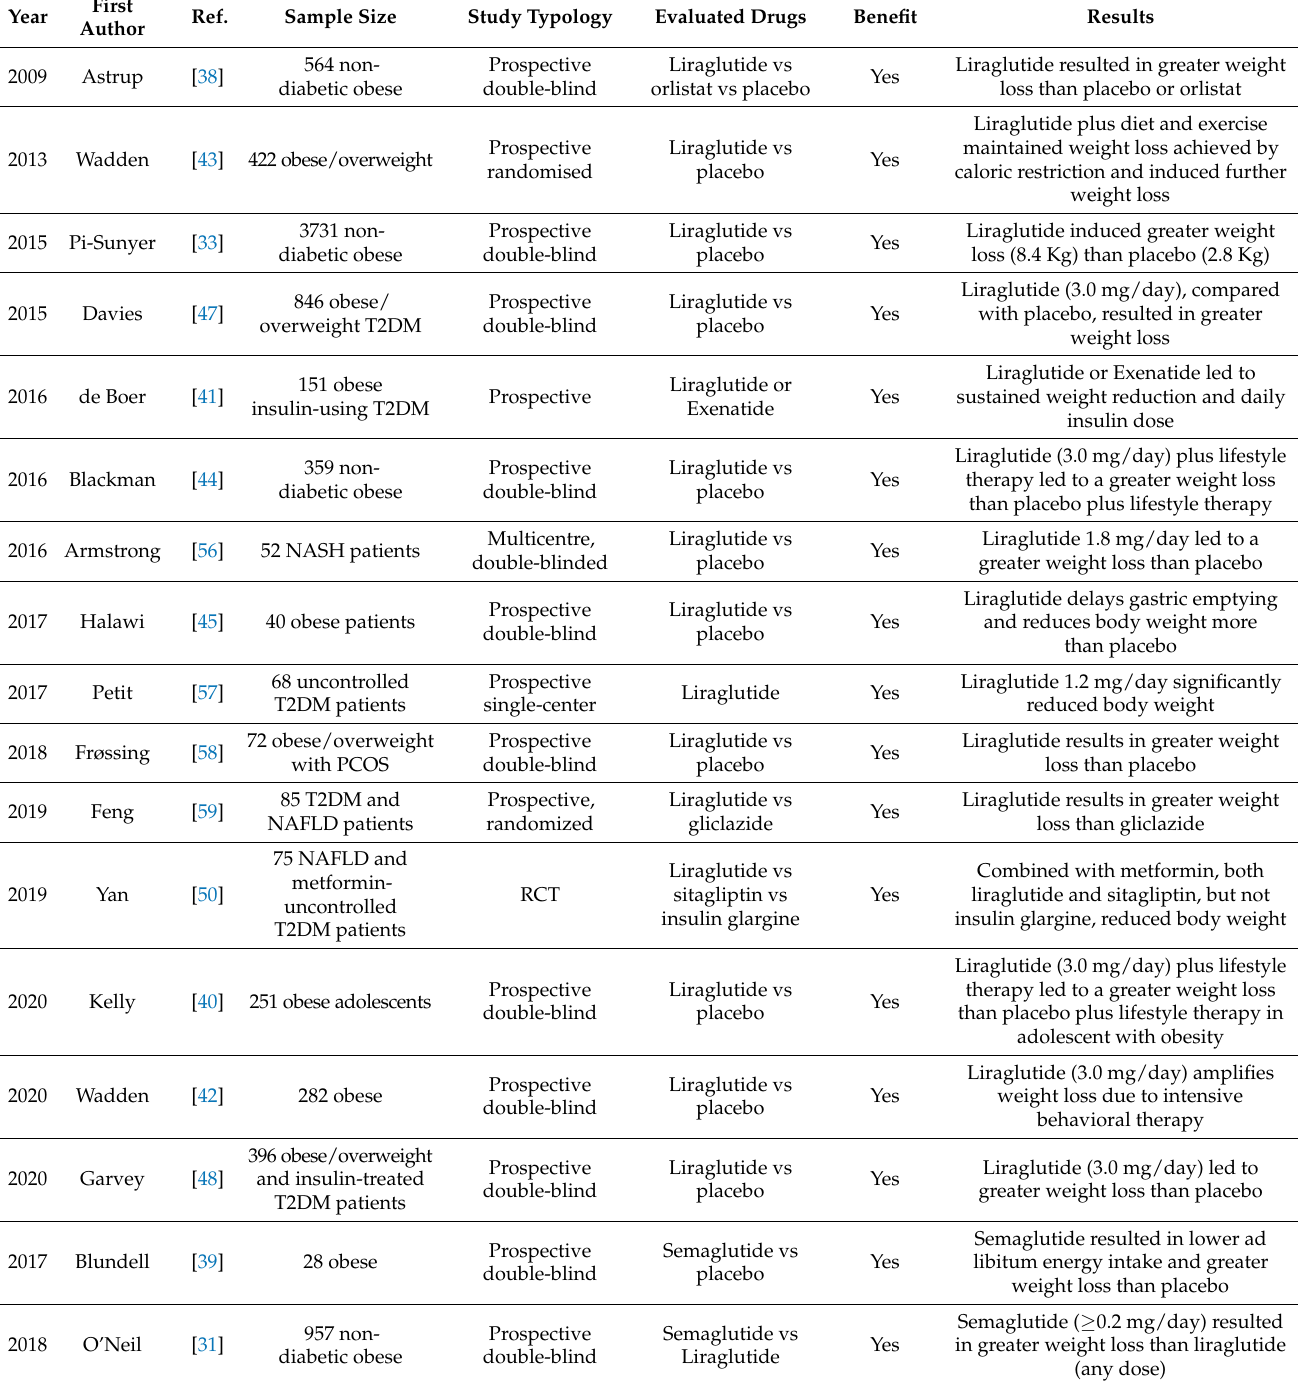
Table 1. Main evidences on the effect of liraglutide and semaglutide on weight